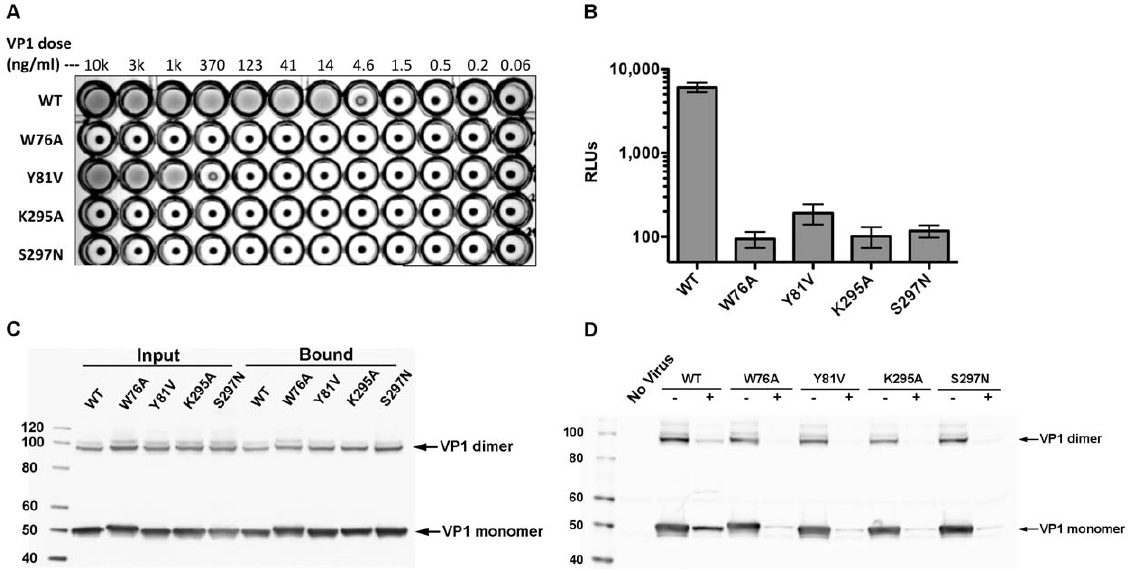
Figure 3. Sialic acid binding site of MCPyV VP1 is crucial for infectivity. (A) Sialic acid binding site mutantions impair hemagglutination. Hemagglutination assays were performed by mixing a suspension of sheep red blood cells with varying doses of purified wild-type (WT) or VP1 mutant MCPyV capsids. (B) Pseudovirus transduction of sialic acid binding site mutants. Human A549 cells were inoculated with WT or mutant VP1 pseudovirions carrying an encapsidated GLuc reporter plasmid. Three days after inoculation, the culture supernatants were tested for GLuc activity (measured in relative light units, RLUs). (C) Cell attachment of sialic acid binding site mutants. A549 cell suspensions were mixed with 150 ng of WT or mutant VP1 capsids for 2 hours at 4 u C. The cells were then washed and subjected to Western blotting using a polyclonal serum specific for MCPyV VP1. In the lanes labeled ‘‘Input,’’ 50 ng of VP1 was loaded into each lane. In the lanes labeled ‘‘Bound,’’ 2/3 rds of the washed cell pellet was loaded into each lane. (D) Cell attachment of sialic acid binding site mutants depends on GAGs. A549 cell suspensions (5 6 10 4 /well) were treated with a mixture of heparinase I (875 mU), heparinase III (87.5 mU), and chondroitinase ABC (35 mU) or mock treated in 50 m l of digestion buffer (20 mM HEPES, pH 7.5, 150 mM NaCl, 4 mM CaCl 2 and 0.1% BSA) for one hour at 37 u C. Then, 200 ng of WT or mutant VP1 capsids diluted in 200 m l of